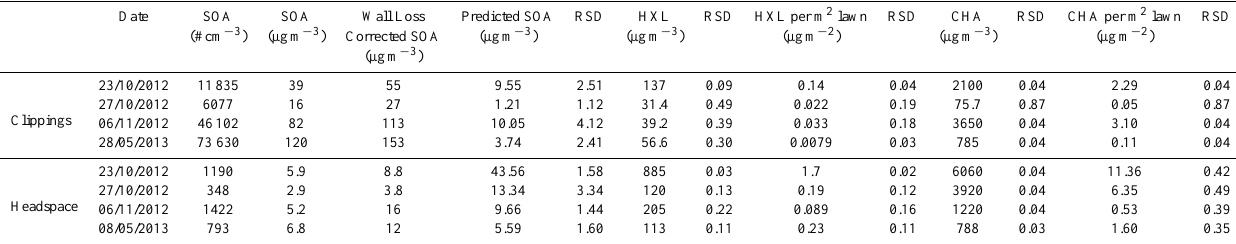
Table 2. Experimental conditions, SOA and GLV results for several grass clipping and headspace experiments. Ozone concentration was ∼ 800 pbb for each experiment. Predicted SOA concentration was determined using initial GLV emissions and wall-loss-corrected aerosol yields. RSD is the relative standard error in the value to the left. RSD of predicted SOA is driven by the high uncertainty in the aerosol yield calculation (Table 1). RSD in HXL and CHA concentrations and masses determined using each GLV